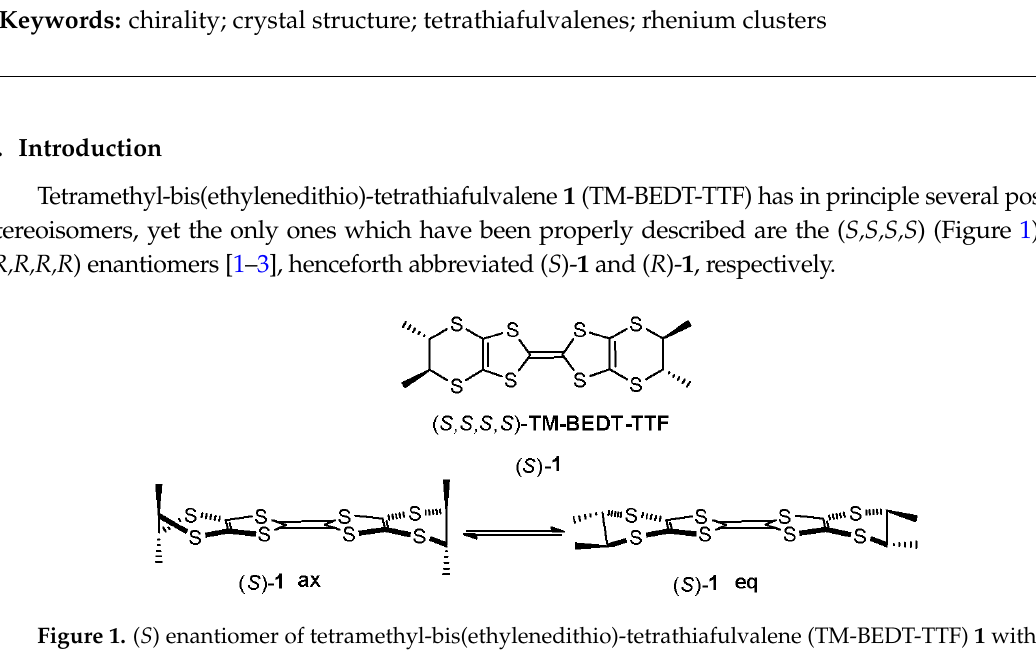
Figure 1. ( S ) enantiomer of tetramethyl-bis(ethylenedithio)-tetrathiafulvalene (TM-BEDT-TTF) 1 with its axial and equatorial conformers.